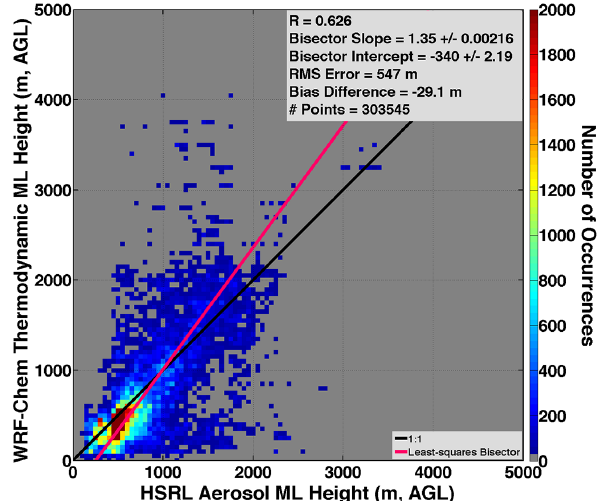
Figure 6. Scatter and bisector regression plot of WRF-Chem ther- modynamic ML and HSRL aerosol ML heights across all flights during CARES. The PBL heights for WRF-Chem are derived from potential temperature. Number of occurrences in each histogram bin is shown in color. The bias difference and RMS difference are cal- culated by WRF-Chem minus HSRL. The number of points in these comparisons corresponds to the HSRL resolution of the backscatter profiles for the 23 CARES flights (1 point ≈ 1km of airborne HSRL